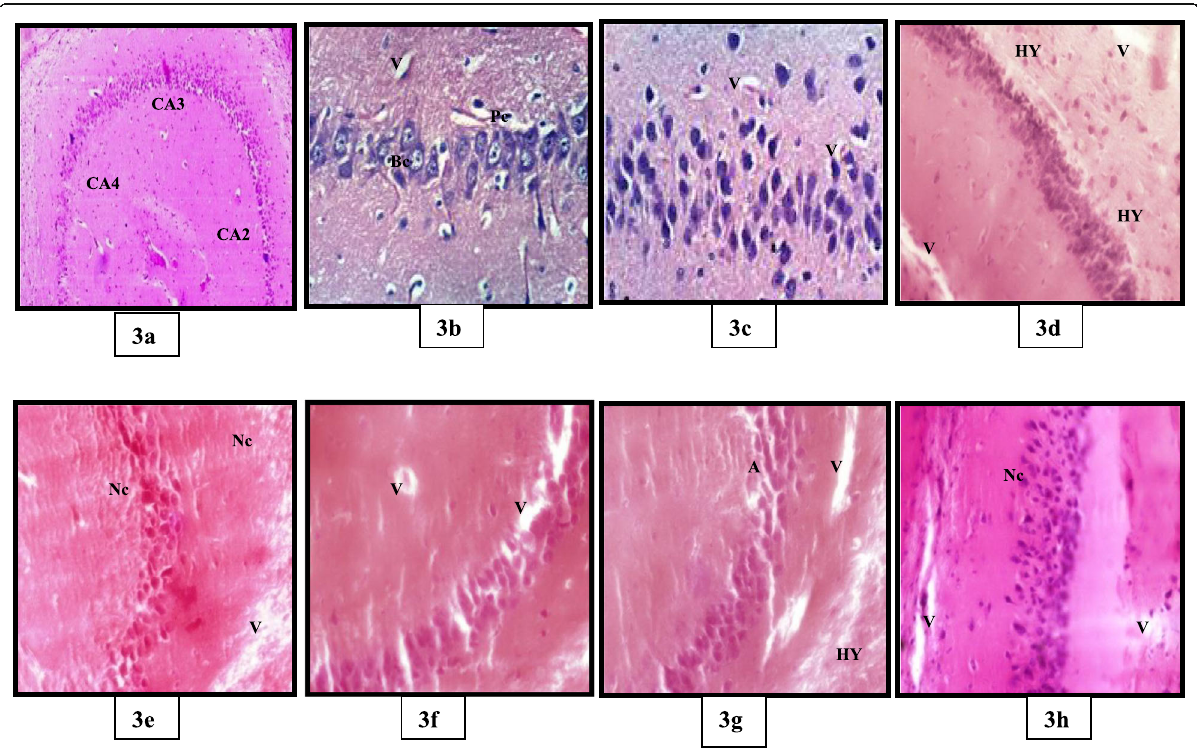
Fig. 3 Photomicrograph of the hippocampus of mice. a Control group showing different regions of cornu ammonis (CA) are visible, i.e., CA2, CA3, and CA4 with innermost network of fibres. × 200 b Cd group showing vacuolation (V), binucleated cells (Bc), and glial cells containing vesicular nucleus. Protective groups c Cd + GE group showing almost normal neurons with a slight distortion in the structure of pyramidal cells. d Cd + TE showing normal thick layer of neurons with normal structure but with slight hyperemia (HY) and vacuolation (V) in the tissue. e Cd + GE + TE showing slight degeneration in the neurons of the hippocampus. Mild necrosis (Nc) and vacuolation (V) is observed in the tissue. Therapeutic groups f Cd + GE showing vacuolation (V) and shrinkage in the neurons, slight hyperemia (HY), and distortion in the shape of the cells. g Cd + TE showing slight atrophy (A) in the structure of neurons. Number of neurons is reduced in the hippocampus (Hp). h Cd + GE + TE showing normal structure. Some necrosis (Nc) and shrinkage of the neurons in all the layers are visible. × 400, H & E